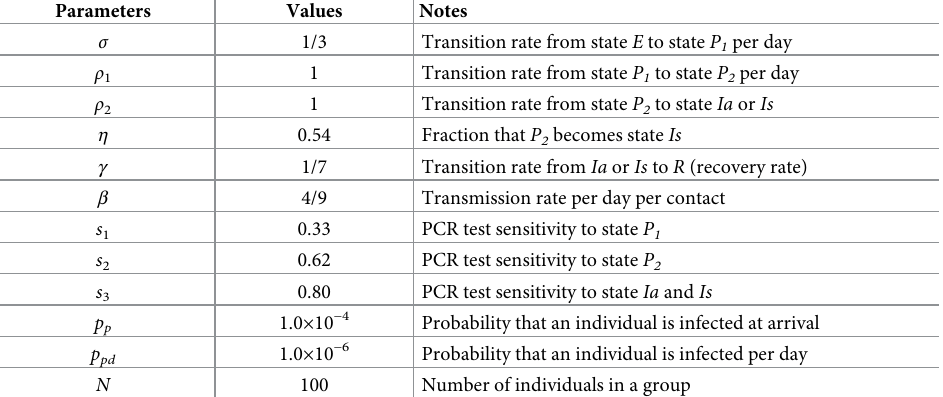
Table 2. Summary of model